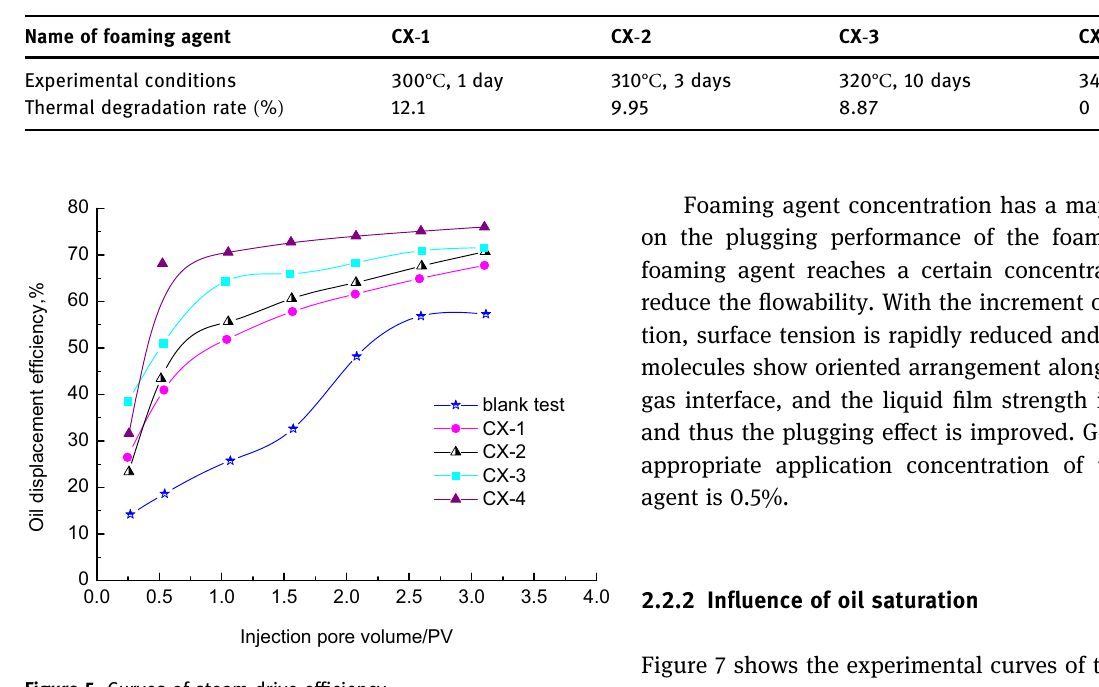
Figure 5: Curves of steam drive e ffi ciency.